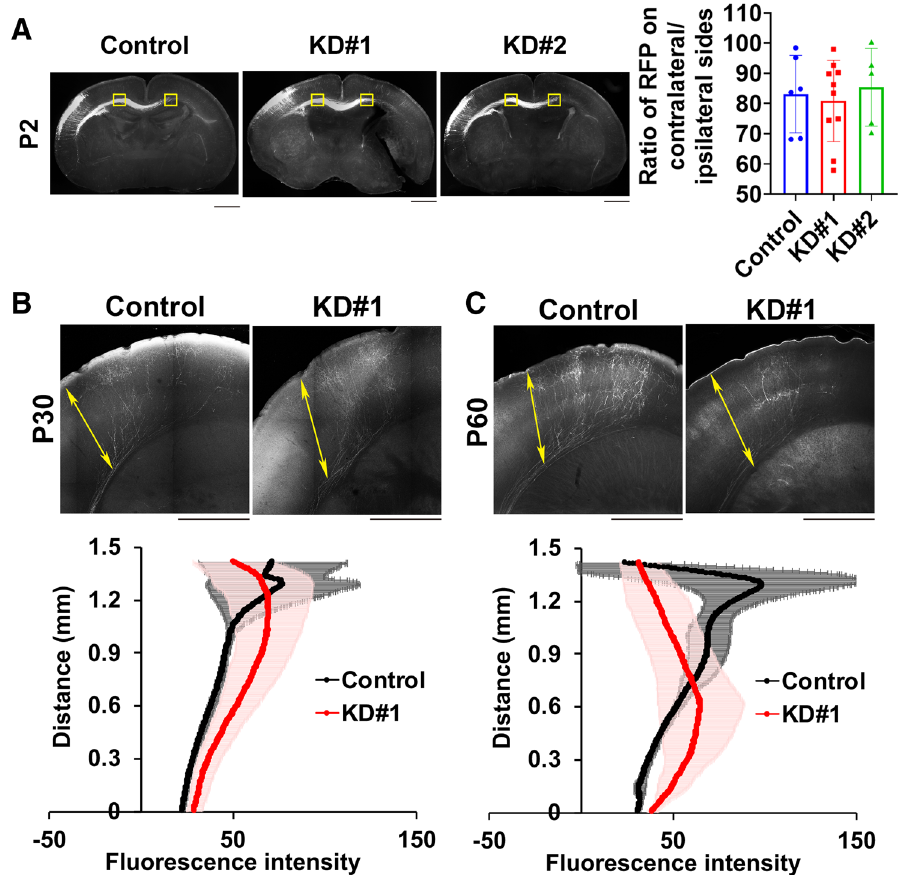
Figure 5. Role of Wdr45 in the callosal axon growth in vivo. ( A ) pCAG-Turbo-RFP was co-electroporated with pSuper-H1.shLuc (control), pSuper-Wdr45#1 or #2 into the VZ progenitor cells at E14.5 and fixed at P2. Coronal sections were then prepared and analyzed. Representative images of callosal axons expressing RFP were shown. Note that Wdr45-deficiency less affected the axon growth at this timing. Quantitative analyses of the ratio of the intensity of RFP-positive axons in the area (yellow) of contralateral cortex to that of ipsilateral one. Error bars indicate SD; Control (n = 6), KD#1 (n = 10), KD#2 (n = 5) from 3 independent experiments; not significant by one-way ANOVA with Tukey’s post hoc test. ( B,C ) Effects of Wdr45-knockdown on axon extension into the contralateral cortex at P30 ( B ) or P60 ( C ). Representative images of the terminal arbors of callosal axons expressing RFP with pSuper-H1.shLuc or pSuper-Wdr45#1 were shown. Quantitative densitometric analyses of RFP fluorescence intensity were performed for axons extending into the contralateral cortical layer structure of control (black line) and Wdr45-deficient (red line) neurons. Distance from the VZ surface along double sided arrows represents the vertical (y) axis. Shadows represent SD [control, n = 3 and KD#1, n = 6 for ( B ); control, n = 3 and KD#1, n = 5 for ( C )]. Scale bars, 50 mm ( A ) and 500 µm ( B